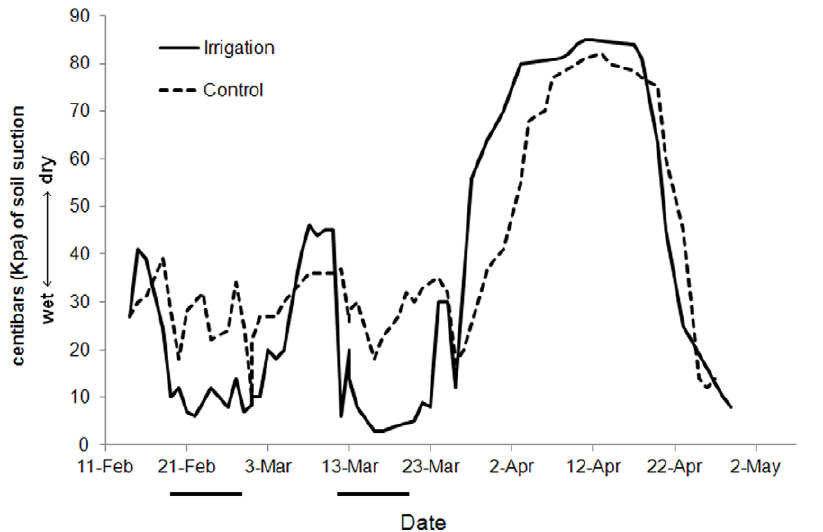
Figure 1. Soil moisture conditions on irrigated and control plots at the Font Hill Nature Preserve, Jamaica. Soil moisture is measured in centibars (Kpa) of soil suction with lower values indicating moister conditions. Irrigation on the plot took place from 19 February to 27 February and 11 March to 19 March (represented by the two black bars under the x-axis).